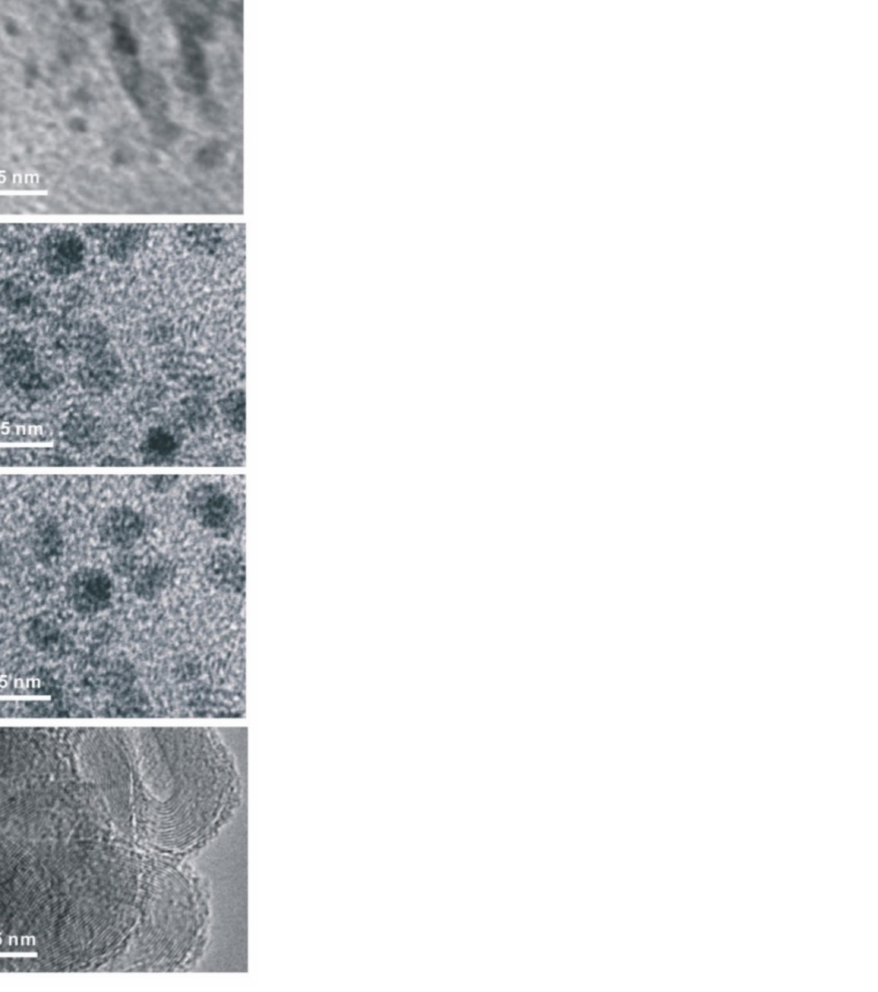
Figure 6. TEM images of carbon nanomaterials obtained by the electro-exfoliation reaction carried out at applied potential of 2.0 V versus Ag/AgCl in 0.01 M of NaOH + 0.1 M of PO 43 − solutions at various temperatures of 0 ◦ C, 20 ◦ C, 30 ◦ C, and 40 ◦ C (Top to bottom respectiverly). To support the experimental observation, controlled electrochemical exfoliation exper- iments with individual electrolytes such as 0.01 M of NaOH, 0.1 M of PO 43 − , and 0.01 M of NaOH + 0.1 M of PO 43 − were carried out at a fixed temperature of 40 ◦ C, respectively. For the case of the 0.01 M of NaOH solution, two size distribution zones